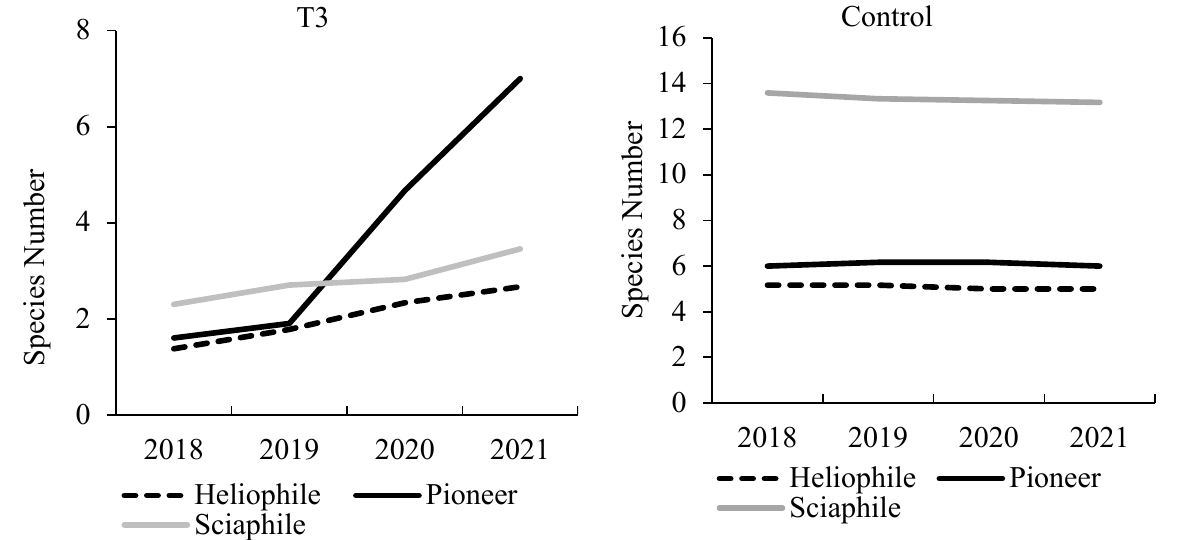
Figure 2. Evolution of the average number of species per treatment. T1 = cocoa plantations which were regularly maintained and exploited, T2 = cocoa plantations which were not maintained but exploited, T3 = cocoa plantations without activities, and Control = a forest relic.